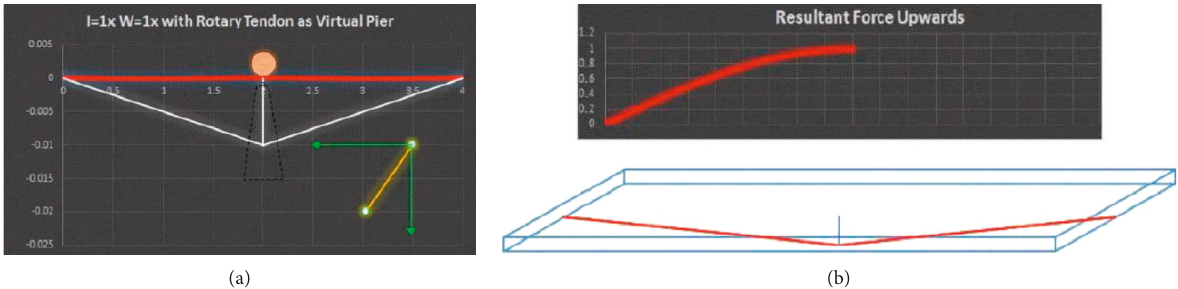
Figure 4: Rotation angle and upwards resultant force for the third stage of a bridge with the NEM.